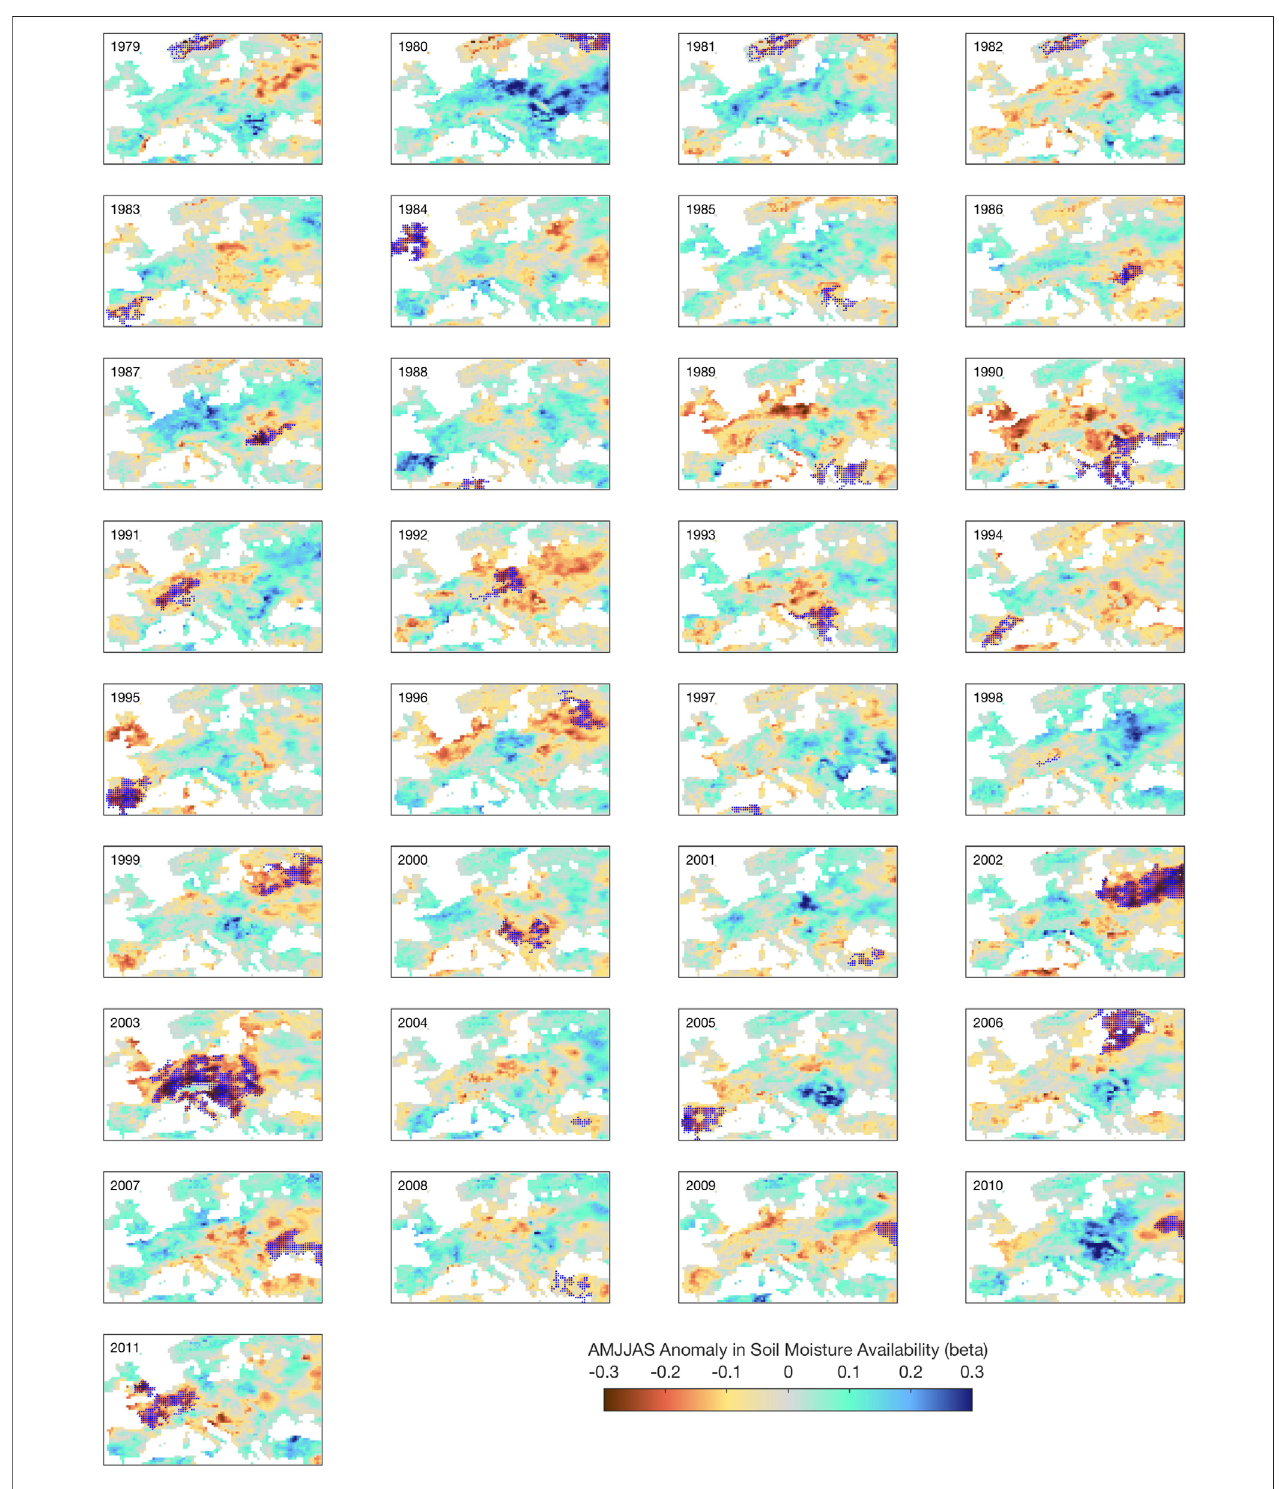
FIGURE7| Annual extent and intensityofdrought anomaliesacrossEurope inthe period 1979 – 2011,asrevealedby the ß factor inthe JULESland surfacemodel (CTL experiment). ß is unitless.